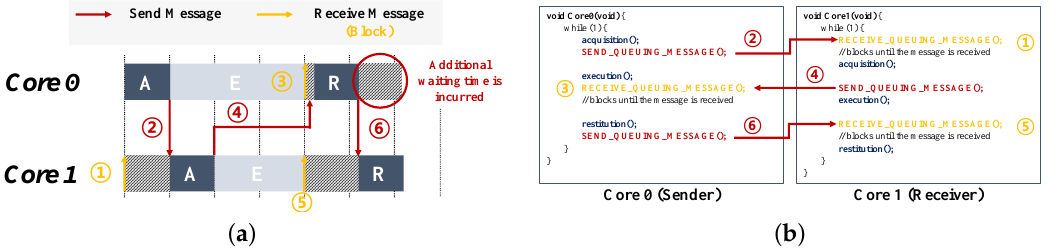
Figure 8. Inter-partition flow control. ( a ) Inter-partition flow control using message queuing. ( b ) Code of inter-partition flow control using message